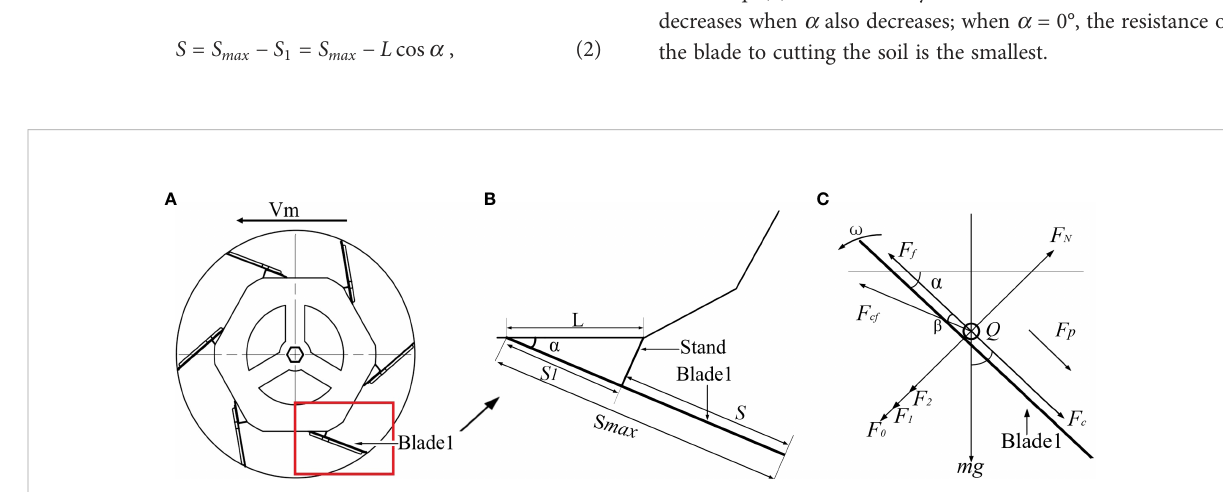
FIGURE 3 Operation of weeding wheel: (A) side view of wheel; (B) enlarged view of blade-attachment site, showing the installation angle a ; (C) soil- particle stress-analysis diagram.